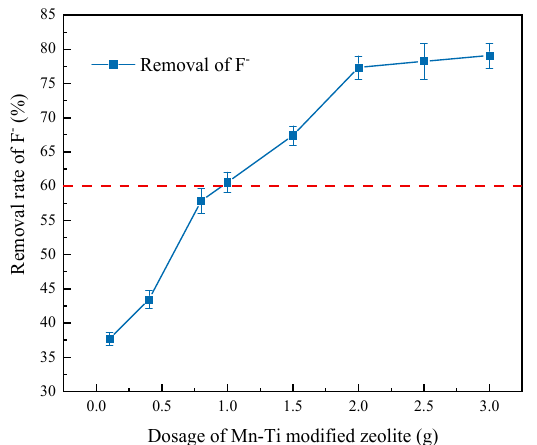
Figure 7. Removal of fluoride ions with different dosage of Mn-Ti modified zeolite. Varying amounts of the Mn − Ti modified zeolite (0.1–3 g) were mixed in a 0.25 L solution with 1 × 10 − 2 g/L initial fluoride concentration at 25 °C and the test time was 4-h.